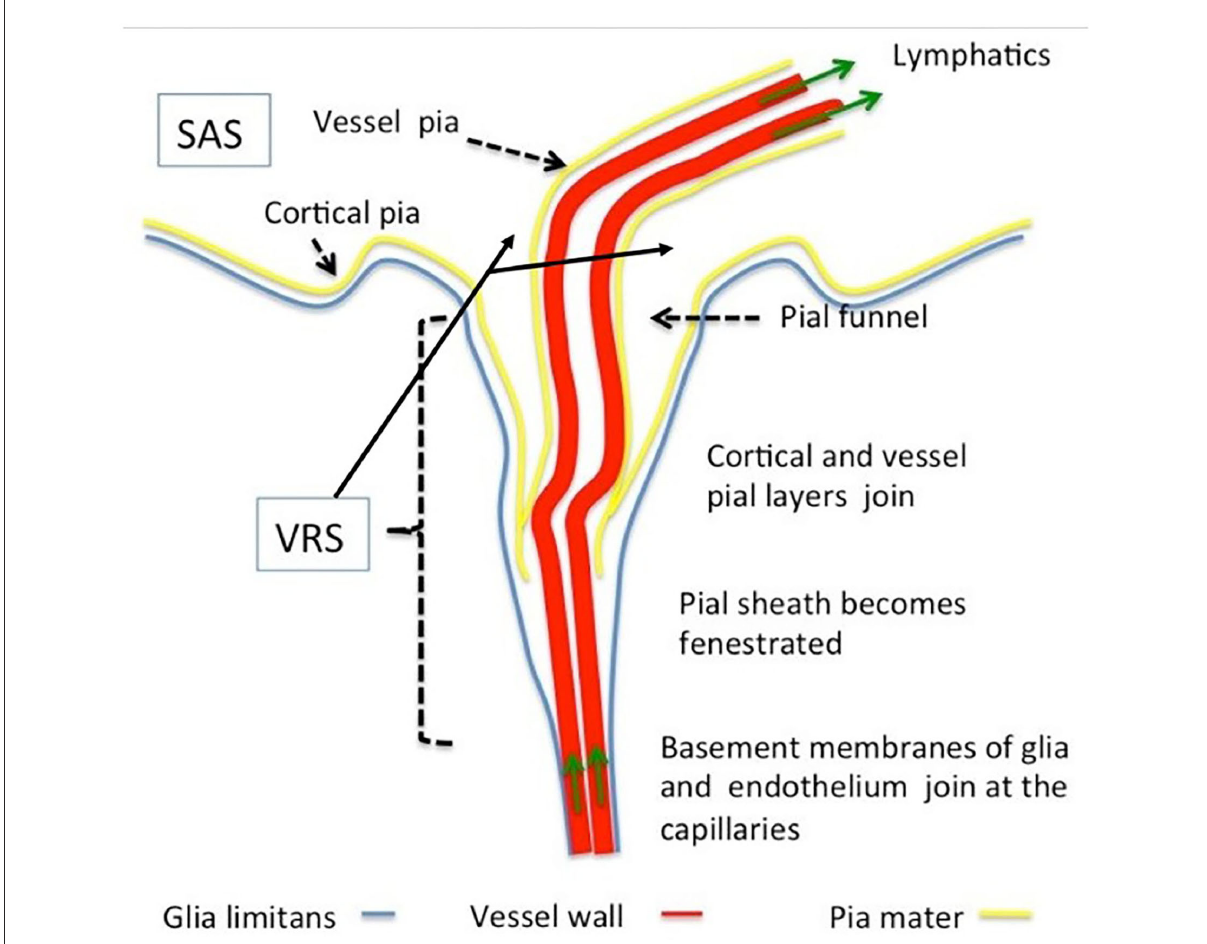
FIGURE2 Morphology of Virchow–Robin and perivascular spaces. The Virchow–Robin space depicts the space surrounding vessels penetrating into the parenchyma with large turning angles [Reproduced from Brinker et al. (22) with permission from the publisher].